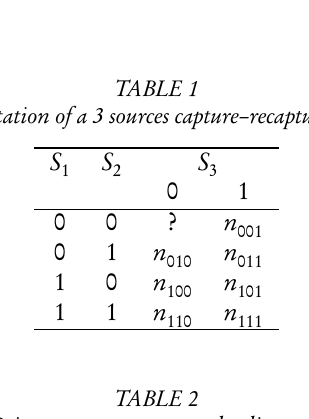
New parameterization for the Poisson capture-recapture log linear model (LLM), referred to the i-th subject belonging to the capture profile 001 with covariate value x.